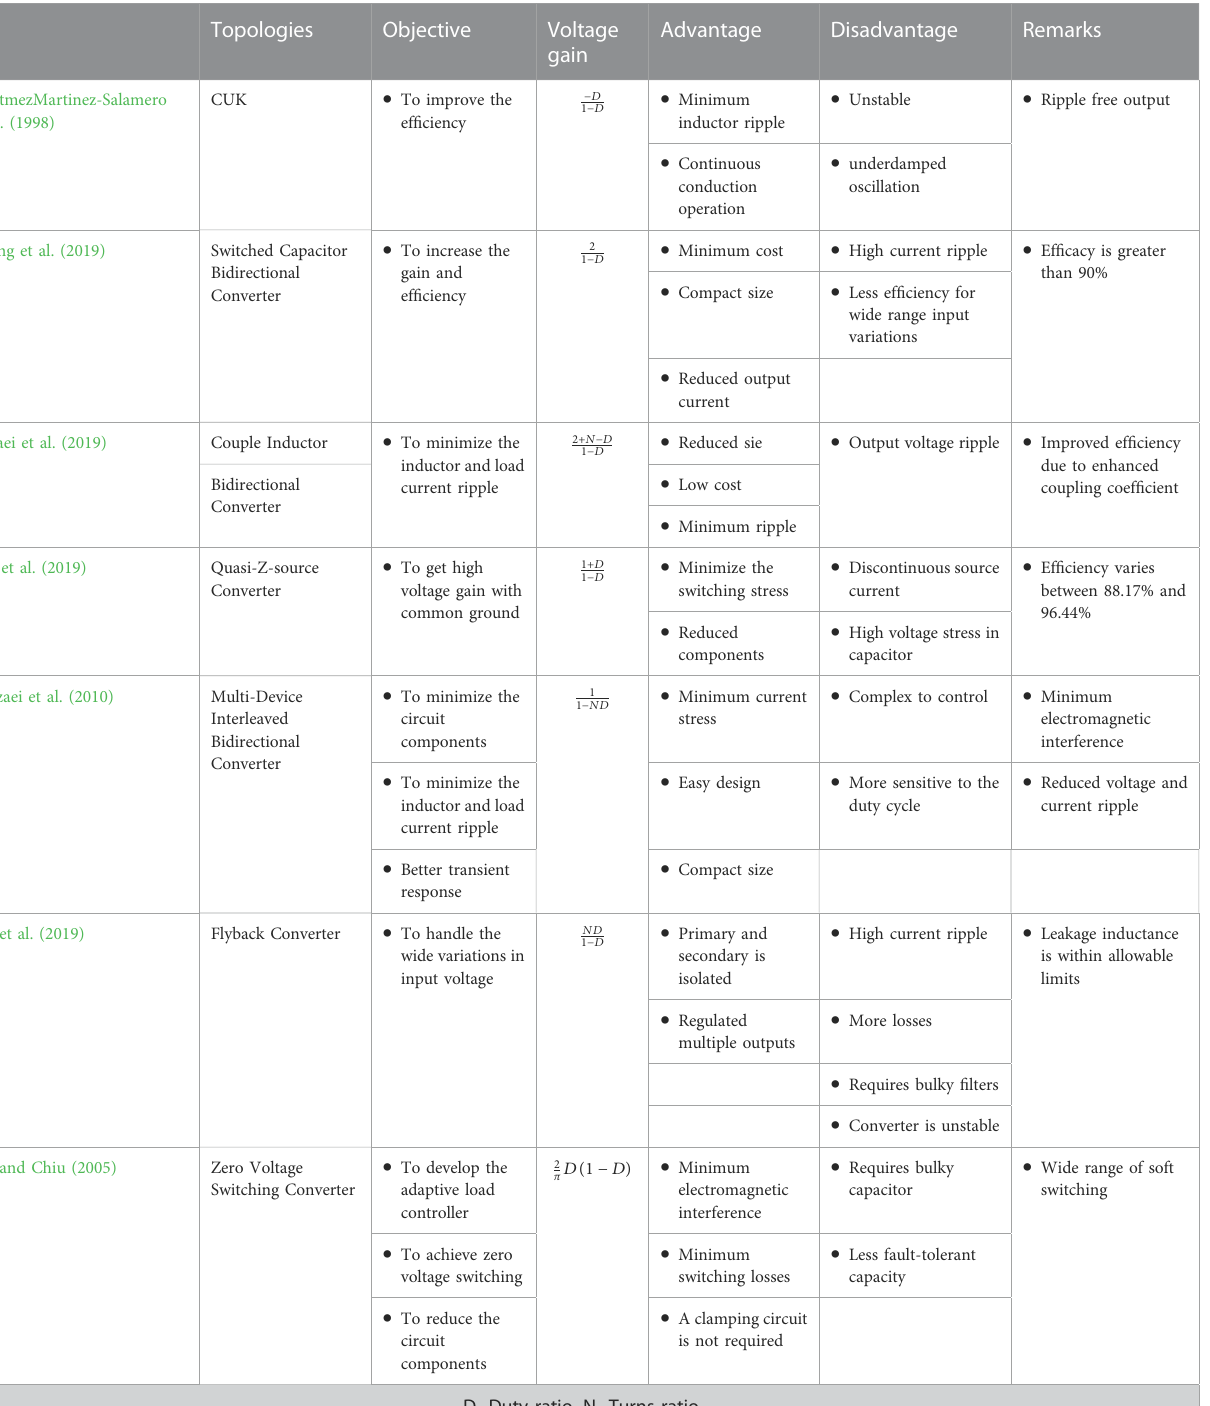
TABLE 5 Summary of various converter topologies for EV